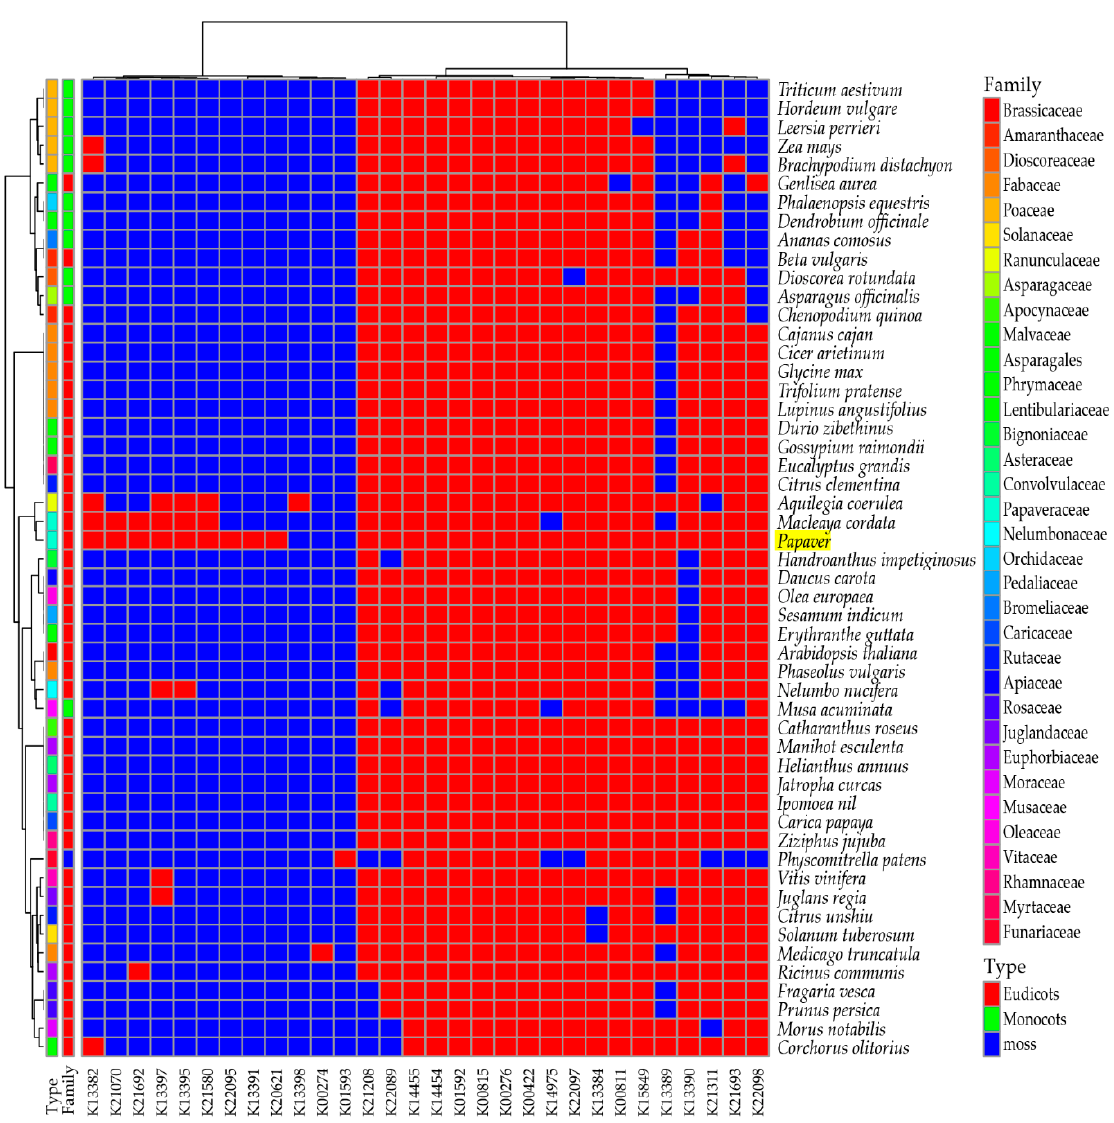
Figure 5. Overview of the isoquinoline alkaloid biosynthesis pathway (map00950). Here the transcripts were linked to the KEGG orthologs (KO), by assessing the sequence similarity between KOs and Papaver transcripts, which was obtained from the ortholog analysis. The expression of the heat map is shown in red (transcripts present) and blue (transcripts absent), this information is obtained from the ortholog clusters.